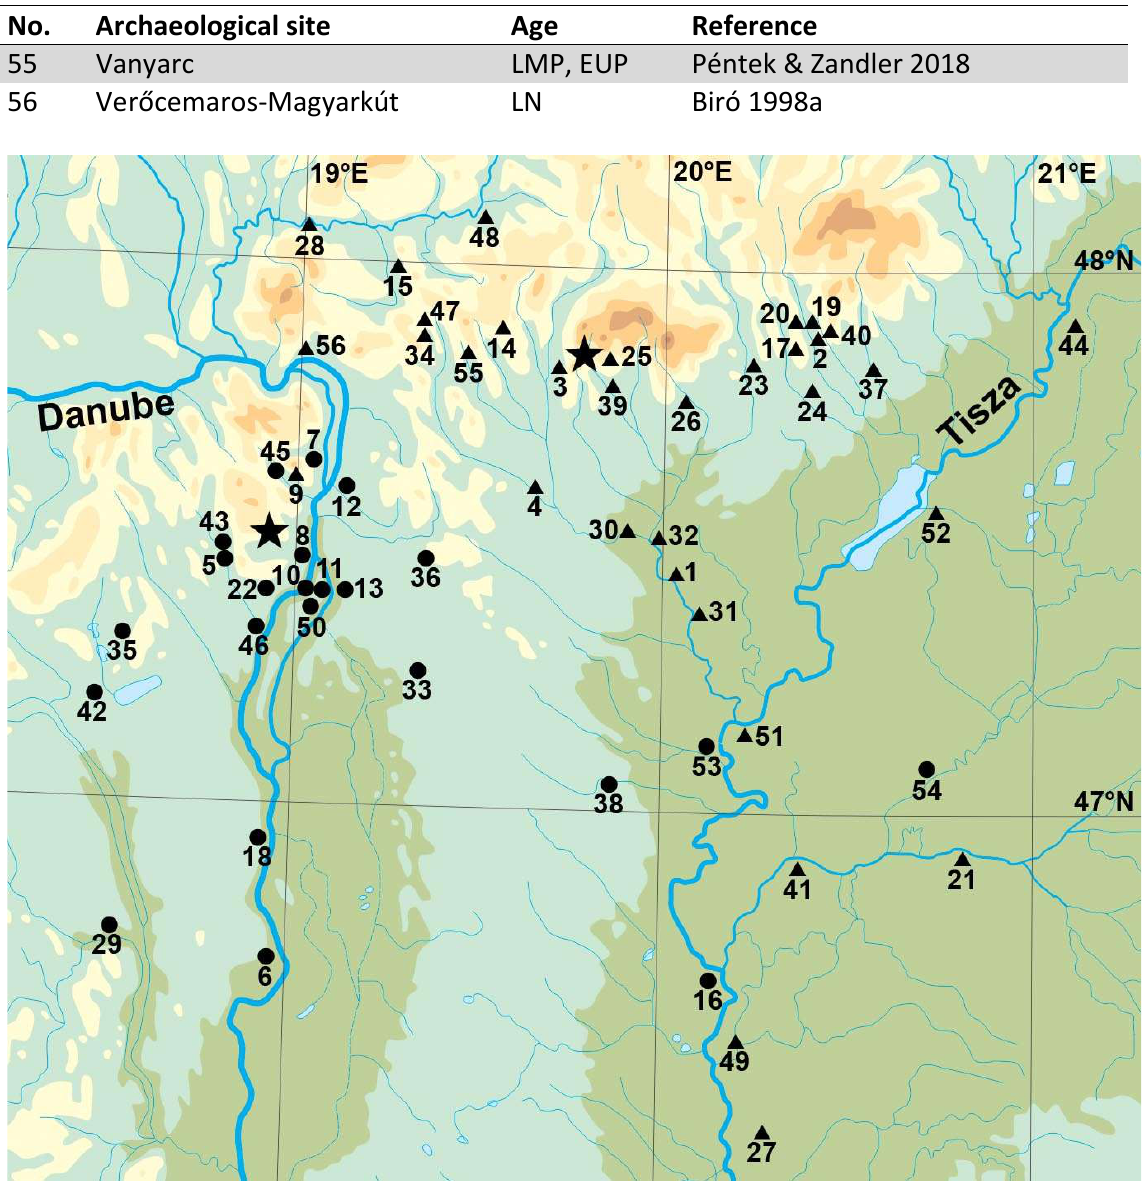
Figure 7. Distribution of the limnosilicites of the Mátra Mountains (triangles) and the Buda hornstone (circles) at archaeological sites in Hungary. For sites see Table 2. (CAD by Z. Mester) Figure 7. Distribution de limnosilicites de la montagne de Mátra (triangles) et celle de la chaille de Buda (cercles) aux sites archéologiques en Hongrie. Pour les sites voir Table 2. (DAO: Zs.